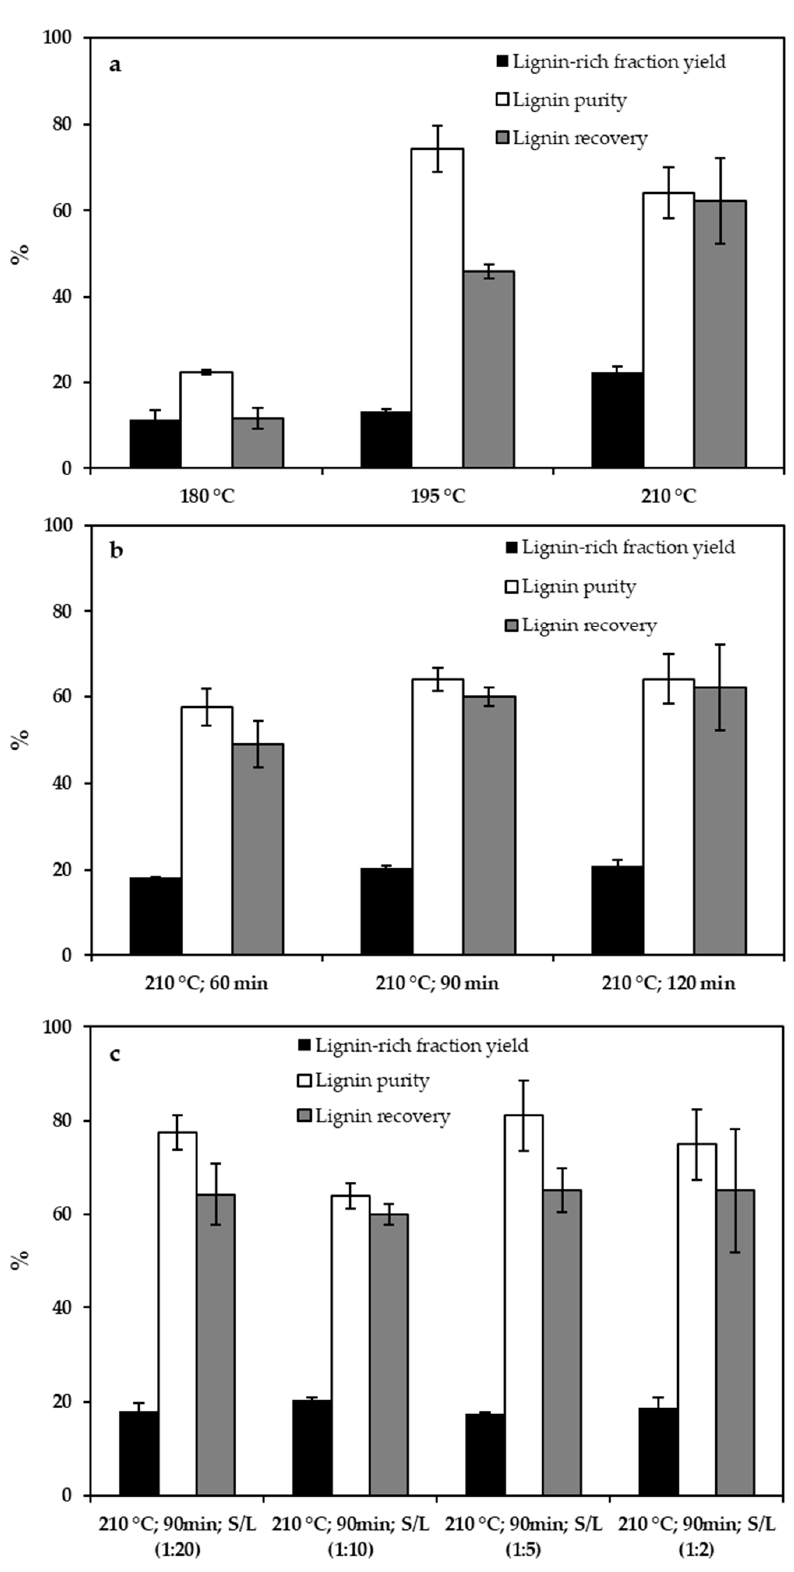
Figure 2. Profiles of the yield of lignin-rich fraction, lignin purity, and total recovered lignin after 240 pretreatment of oat husks at varying temperatures ( a ), retention times ( b ), and solid-to-liquid ratios 241 (S/L) ( c ). 242